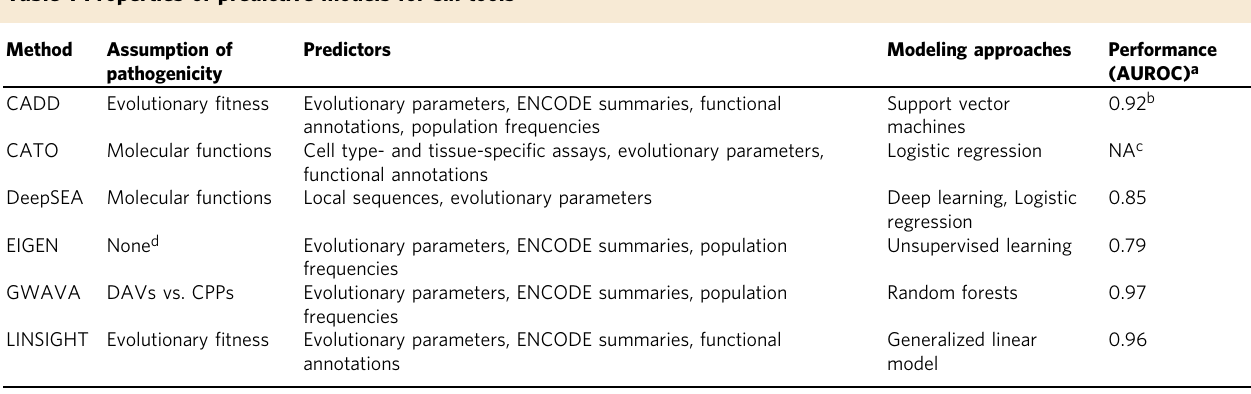
Table 1 Properties of predictive models for six